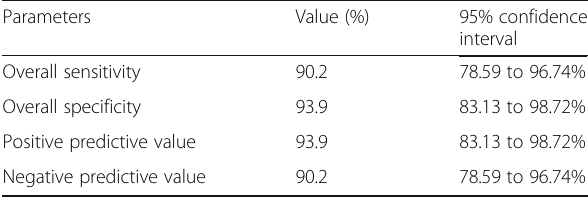
Table 3 The sensitivity, specificity, and predictive values of PCR